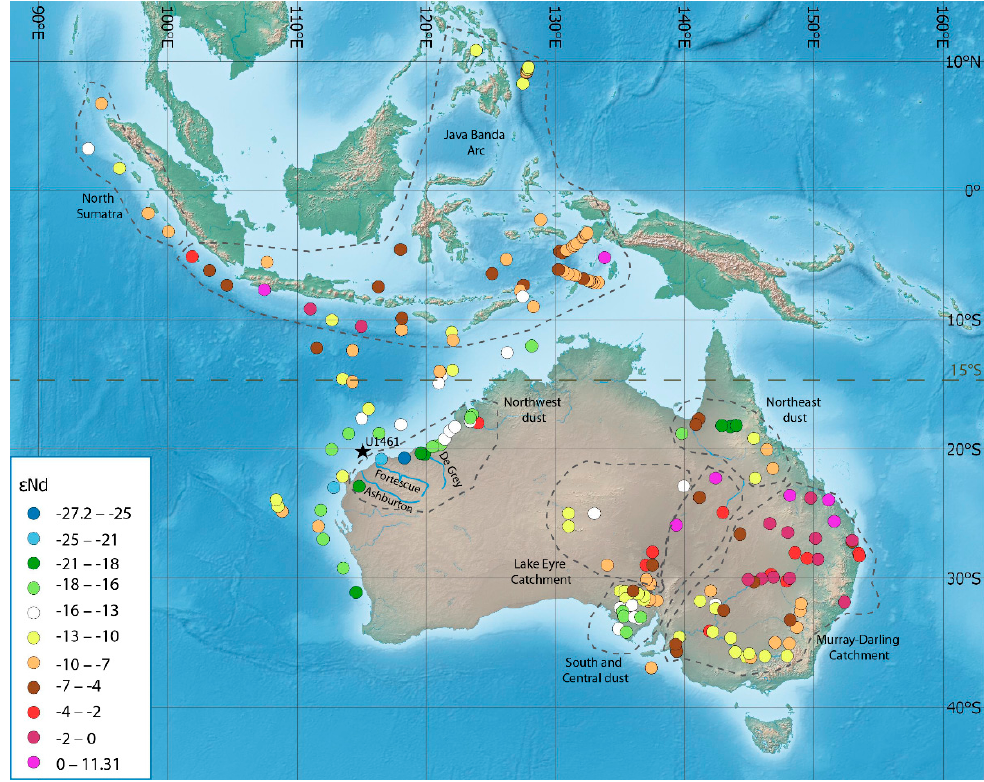
Figure 7. Nd isotopic composition of the surface sediments in Indo-Pacific [10,26,83–89] . Black star indicates the location of Site U1461. Dotted lines indicate the geographical zonation of North Sumatra, Java Banda Arc, northwest dust, northeast dust, Lake Eyre catchment, Murray-Darling catchment, and South and Central dust.